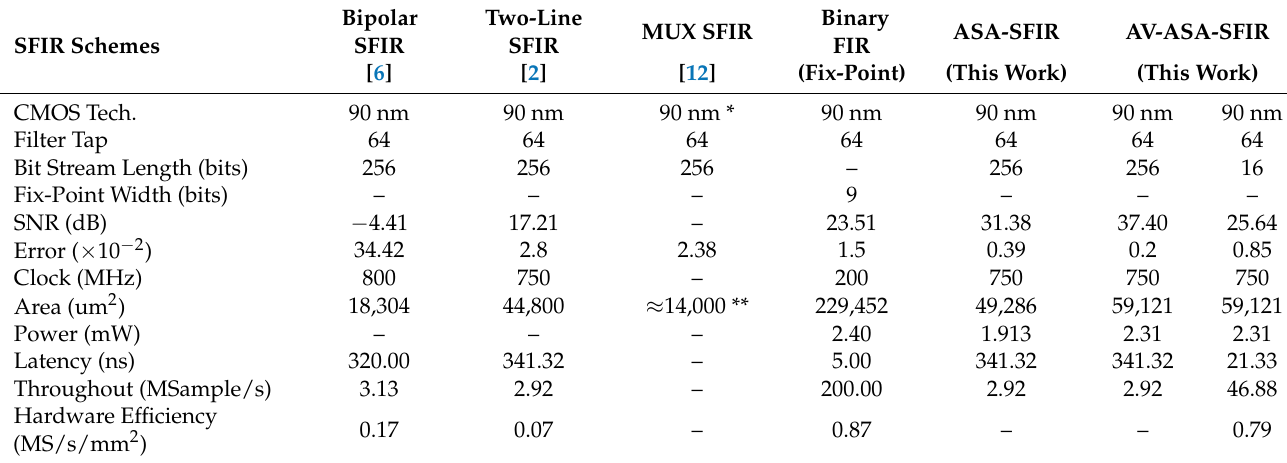
Table 1. Implementation results